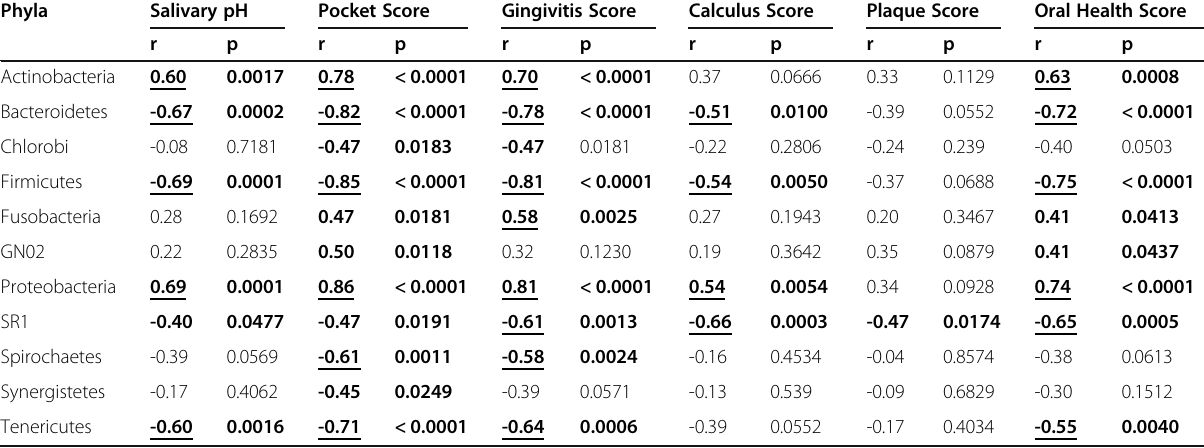
1 Bold correlation coefficients (r) with p <0.05, and underlined correlation coefficients (r) with r>0.5 (strong